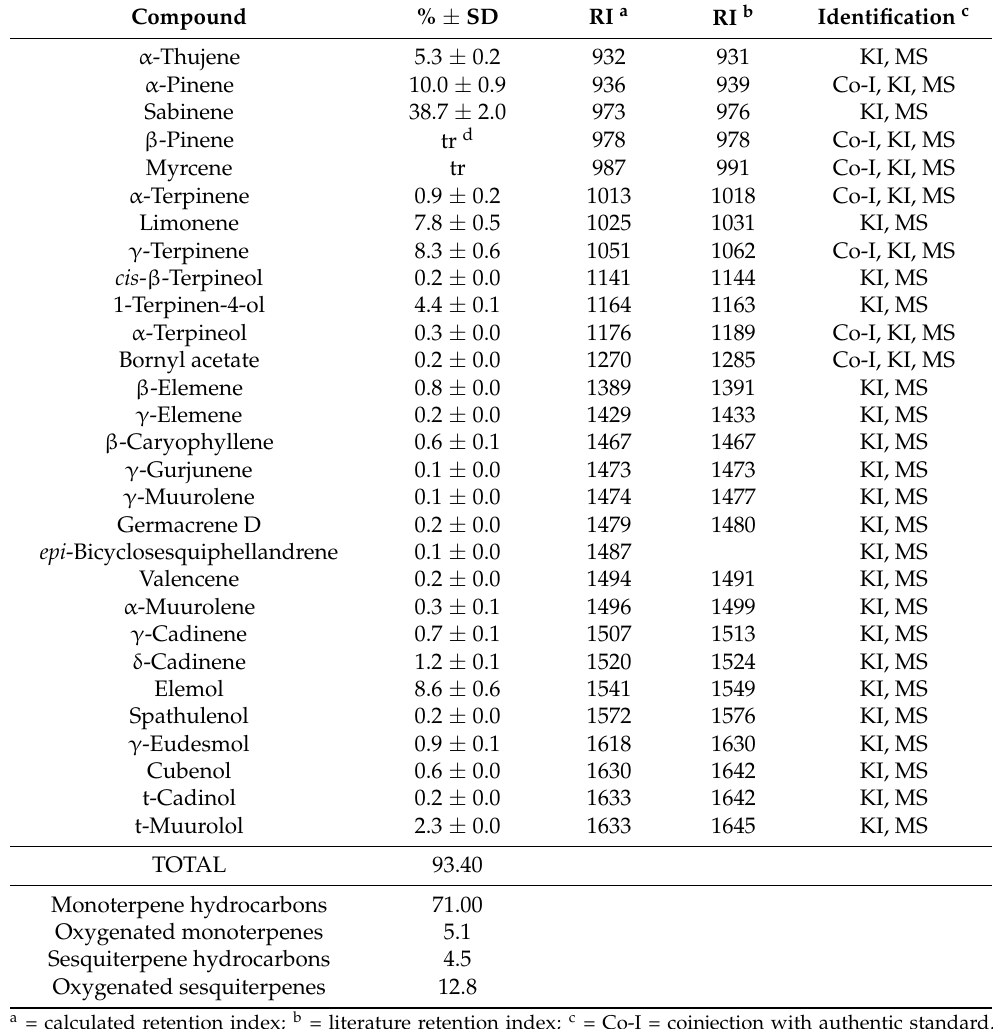
Table 1. Chemical composition of the essential oil of Juniper horizontalis .